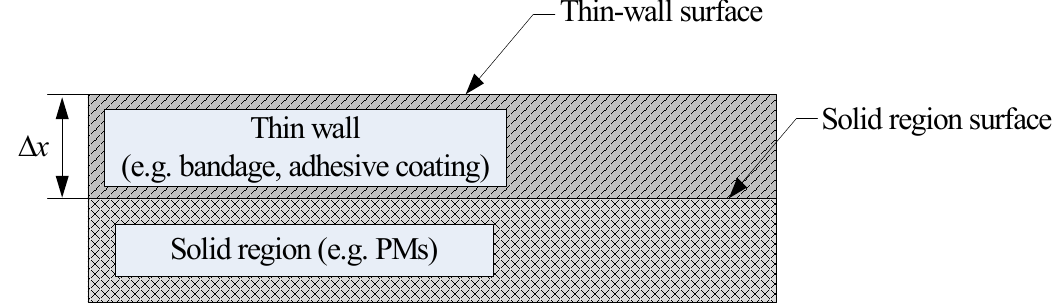
Thin-wall surface